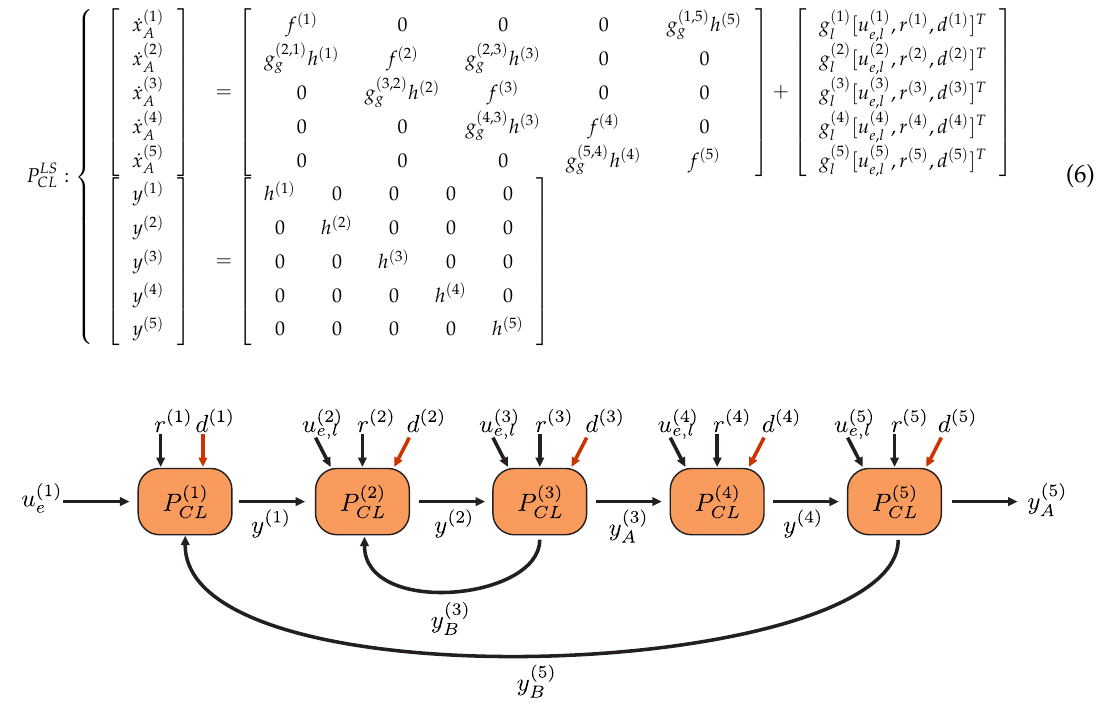
Figure 6. Example for a large system P LS with two recycle flows between two